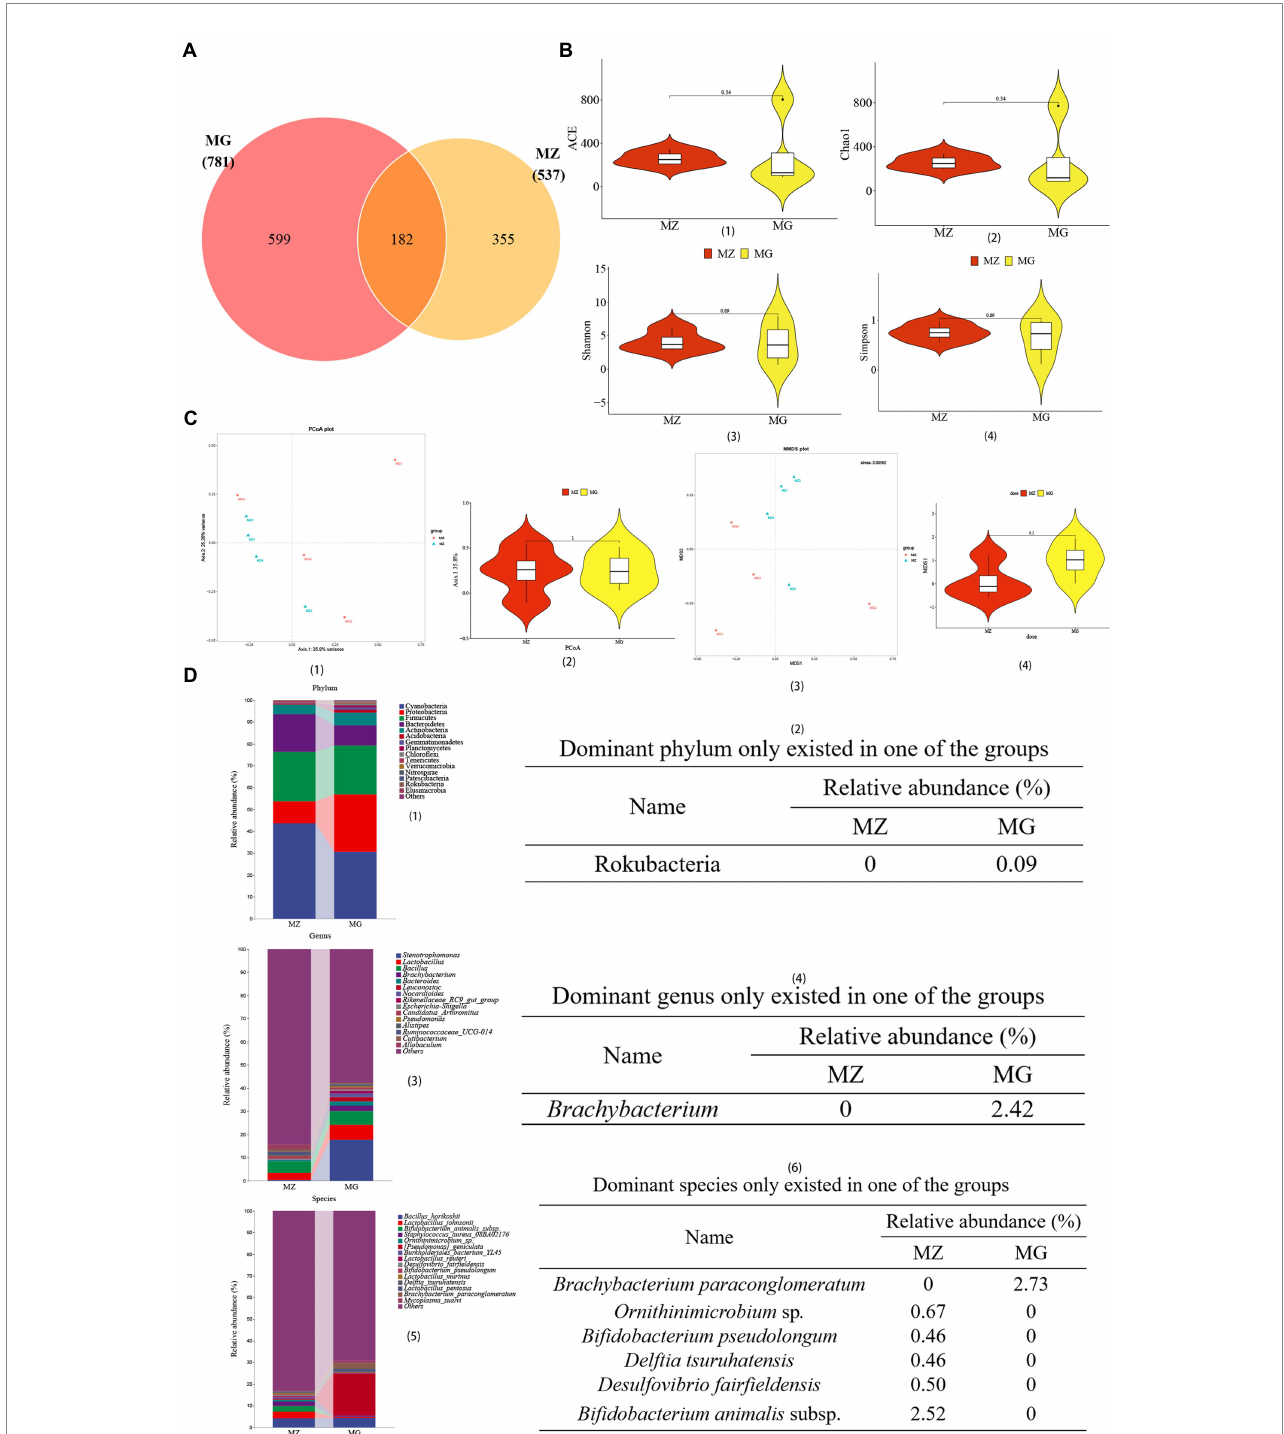
FIGURE 4 High-salt diet induced changes in OTU annotation, gene richness, and microbial composition in rats. (A) Venn diagram of OTU. (B) Distribution illustration of samples gene representative of OTU number in community (ace index) (1), community richness (chao1 index) (2), and community diversity (Shannon index and Simpson index) (3, 4). (C) PCoA plot (1, 2), NMDS plot (3, 4). (D) Dominant intestinal mucosal microbiota composition and dominant microbiota only existed in one of the groups at the level of phylum (1, 2), genus (3, 4), and species (5, 6). MZ, normal group, MG, hypertensive